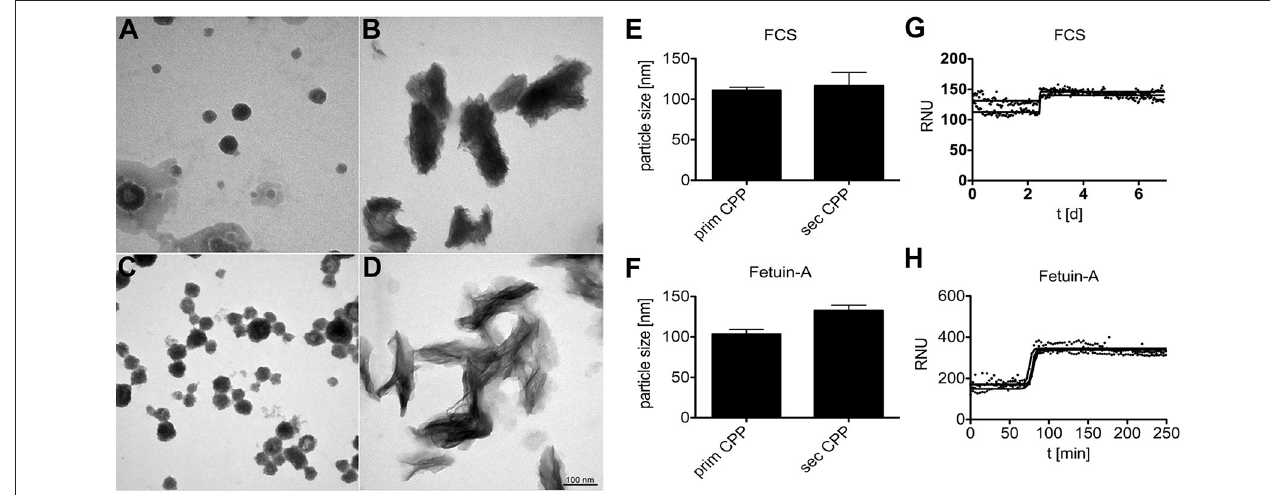
FIGURE 1 | Calciprotein particle CPP formation in protein solutions supersaturated with calcium and phosphate. (A,B,E,G) CPP were prepared in DMEM supplemented with 1.0mM calcium (total Ca 3.8mM), 3.5mM phosphate (total Pi 4.4mM), and 10% fetal calf serum FCS. (C, D,F,H) Alternatively, CPP were prepared in HEPES/NaCl buffer supplemented with 10mM calcium, 6mM phosphate, and 1.0 mg/ml purified fetuin-A protein. (A–D) CPP were harvested by centrifugation and analyzed by electron microscopy or by nanoparticle tracking analysis (E,F) . (A–D) Depict representative CPP in their primary (A,C) and secondary (B,D) state. DMEM/FCS-derived and HEPES/fetuin-A-derived primary CPP were similar, but DMEM/FCS-derived secondary CPP appeared denser, yet less crystalline because of higher protein content. Electron microscopy shows that primary and secondary CPP are distinct in shape and size, while nanoparticle tracking analysis (E,F) indicated similar particle sizes of around 100–125nm for all preparations. Continuous nephelometer measurements (G,H) indicated a sharp transformation of primary into secondary CPP around 2.5 days and 75min in the presence of DMEM/FCS and HEPES/fetuin-A protein, respectively.